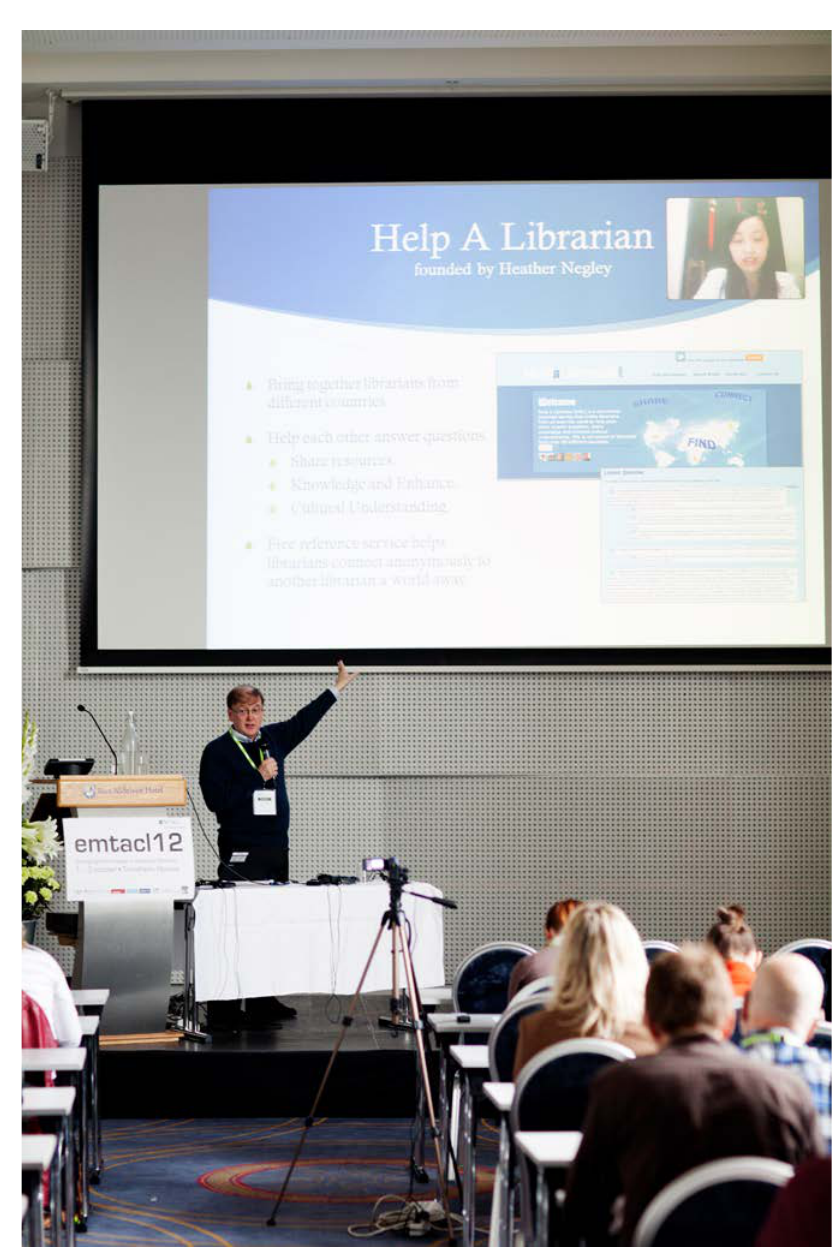
Presentation at emtacl12, Trondheim, Norway, October 2, 2012, with Mark Puterbaugh on site and Hua Sun using Skype from China. Photograph by Nils Kristian Th.